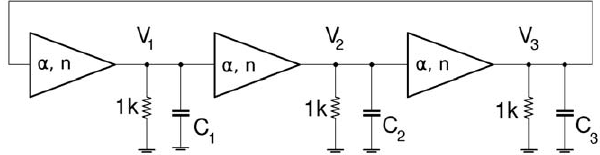
Figure 4. Electronic repressilator. Repressilator circuit constructed from a loop of three of the negative regulatory gene circuits of Fig. 1.